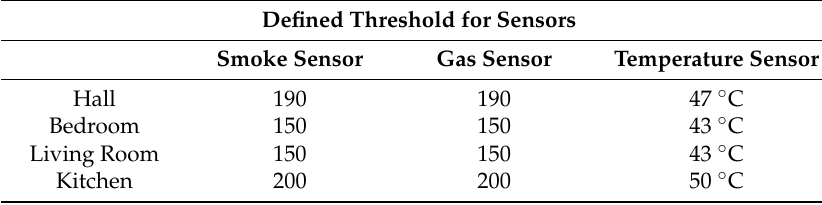
Table 1. Defined Threshold for